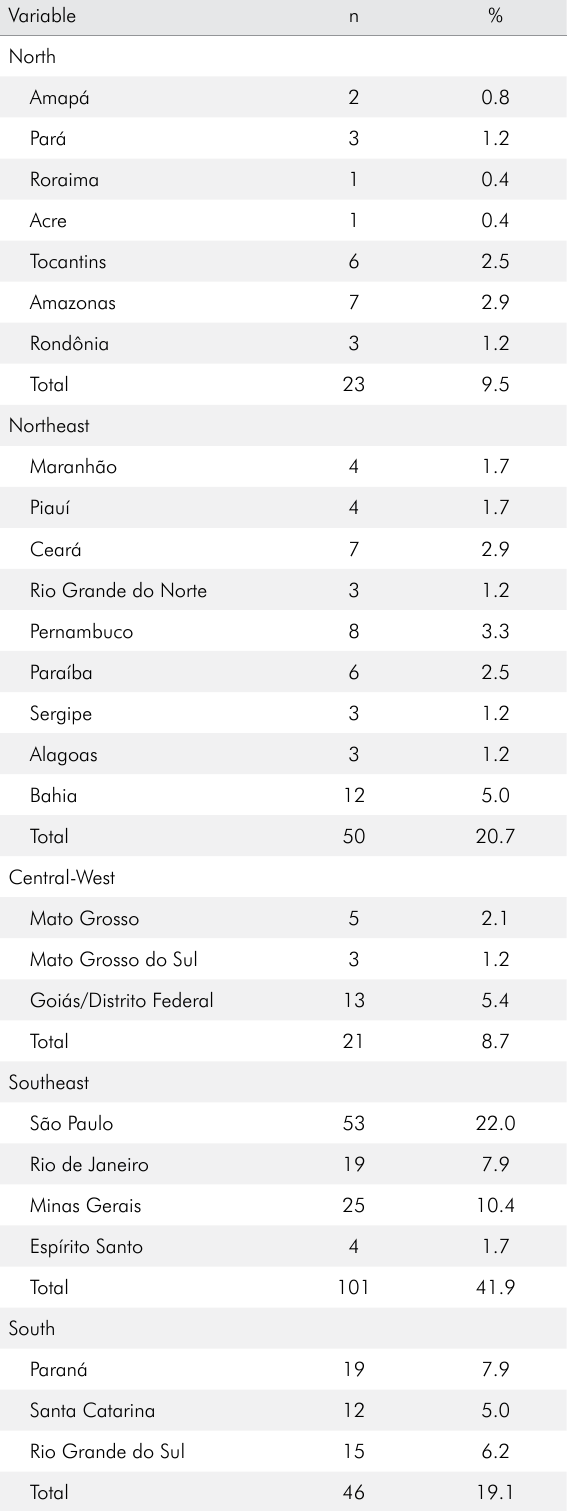
Table 1. Macroregional distribution of regulated dentistry courses in